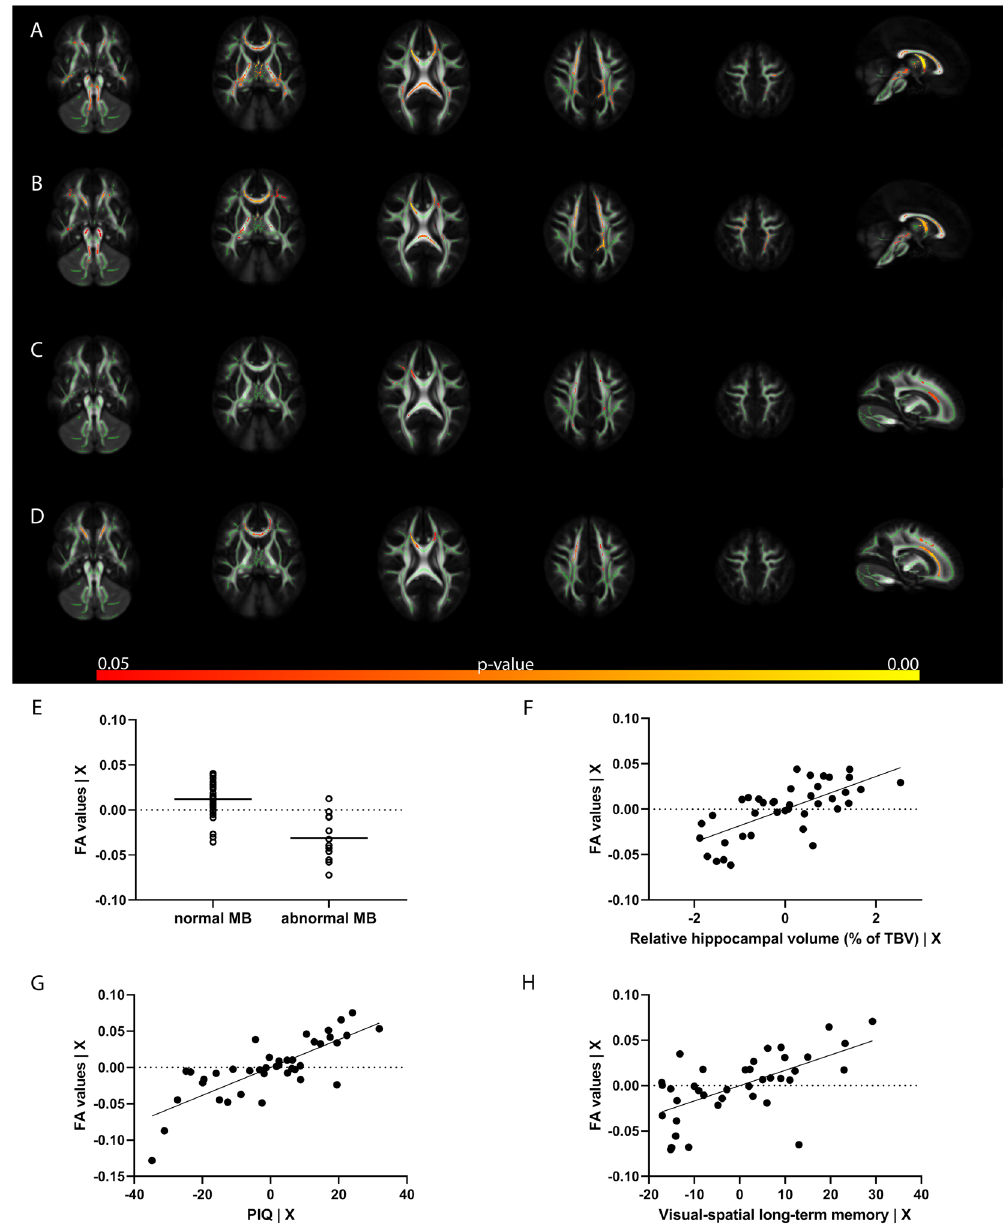
Figure 3. TBSS results. Results of TBSS analyses with five axial views and one midsagittal view for the MB ( A ) and hippocampus ( B ) and a parasagittal view for the neurocognitive and memory measures ( C , D ). All analyses were corrected for age and sex. This figure shows the associations between FA values and MB ( A , E ), relative hippocampal volume ( B , F ), PIQ ( C , G ) and visual-spatial long-term memory (delayed recall) ( D , H ). In the plots the unstandardized residuals for the FA values corrected for age and sex are visualized on the y axis, and the MB ( E ) or the unstandardized residuals for relative hippocampal volume ( F ), PIQ ( G ) or visual-spatial long- term memory ( H ) corrected for age and sex on the